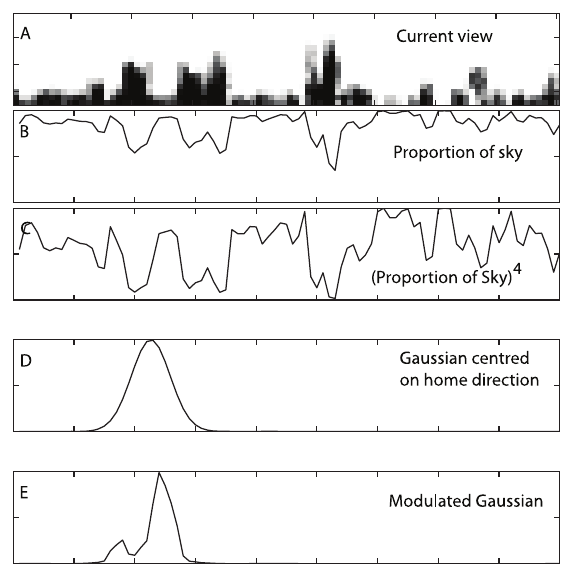
power of 4, v 4 (Figure 11C). The resulting modulated Gaussian (Figure 11E) was renormalized and sampled from to determine a movement direction and a 4 cm step was taken in this direction. Training images are collected after every step. The obstacle avoidance modulation has the effect of biasing movements towards lower portions of the horizon while preventing completely movements towards objects that fill the entire visual field in the vertical direction. Due to the sampling involved in this process, individual paths between two locations will vary slightly allowing the collection of subtly different sets of images describing a route. A return path was considered complete when the distance to the nest was less than 4 cm.